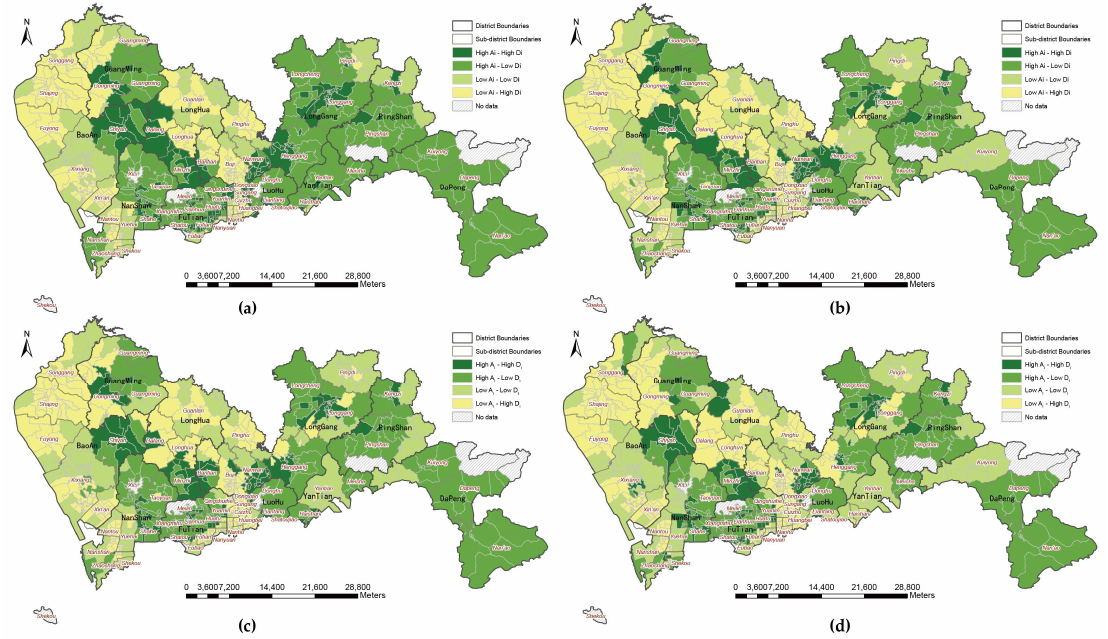
Figure 10. Park accessibility and its associations with population density under four types of travel distance: ( a ) Euclidean distance; ( b ) walking distance; ( c ) bicycling distance; ( d ) driving